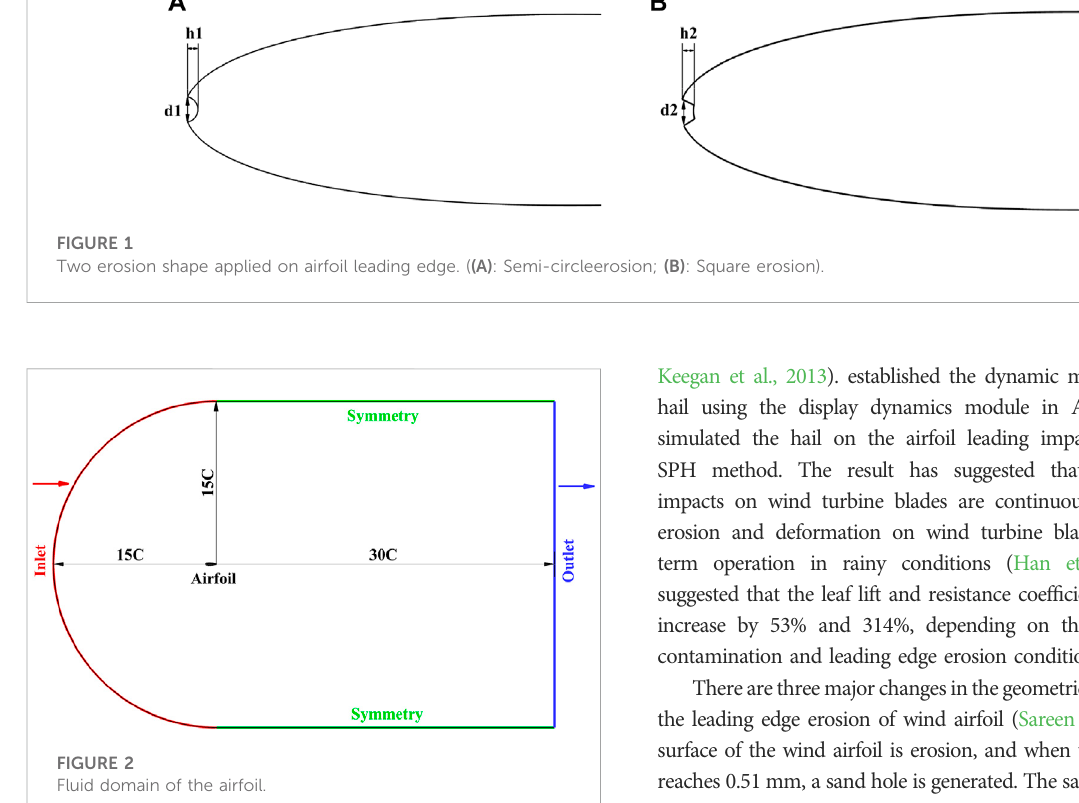
FIGURE 2 Fluid domain of the